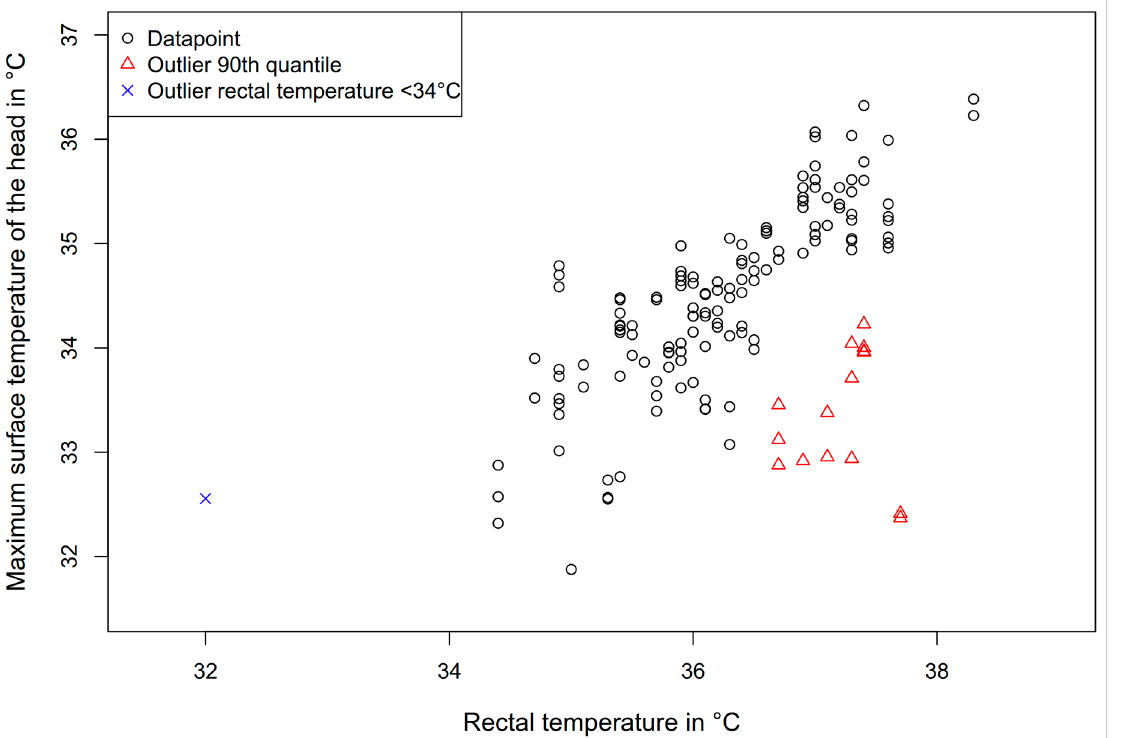
Figure 5. Outlier detection: blue cross indicates a rectal temperature <34 ◦ C and red triangles indicate 10% of the biggest differences between rectal temperature and max surface temperature of the piglet’s head. Table 2. Indexing of features. Where mb = max back, mbe = max back end, mh = max head, mp = max piglet, ab =average/mean back, abe = average/mean back end, ah = average/mean head, and ap = average/mean piglet.